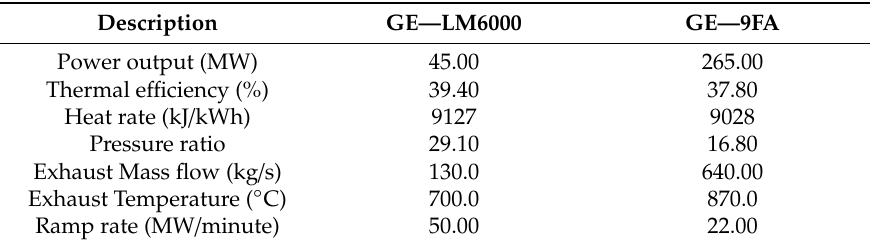
Table 2. The selected gas turbine engines from Kuwait power system.